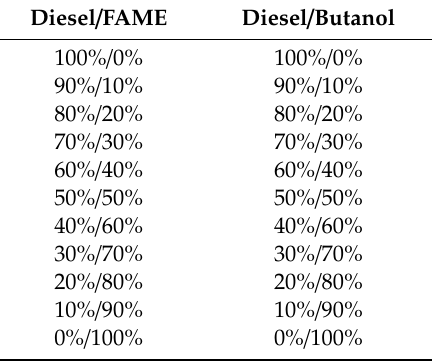
Table 3. Proportions of fuels used in the